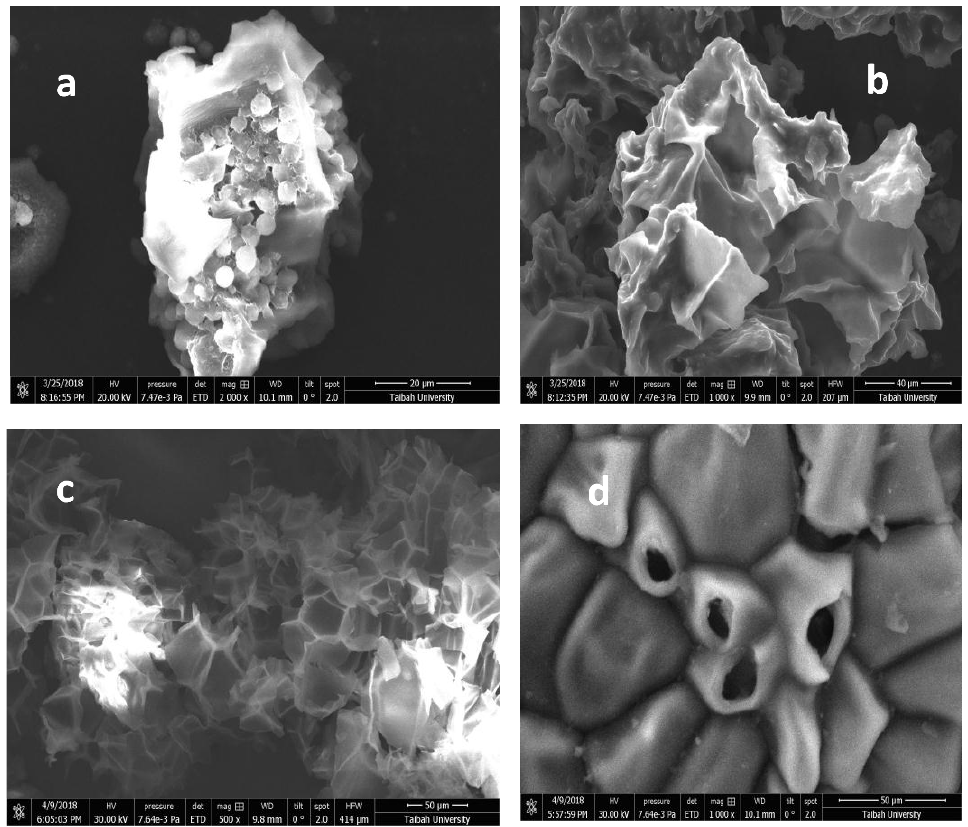
Figure 14. Micrographs of the scanning electron microscopy for ( a ) the parent MNS-4 and ( b ) after MB removal. ( c ) Corresponds to the regenerated material (washed with ethanol and water mixture) and ( d ) after reuse.